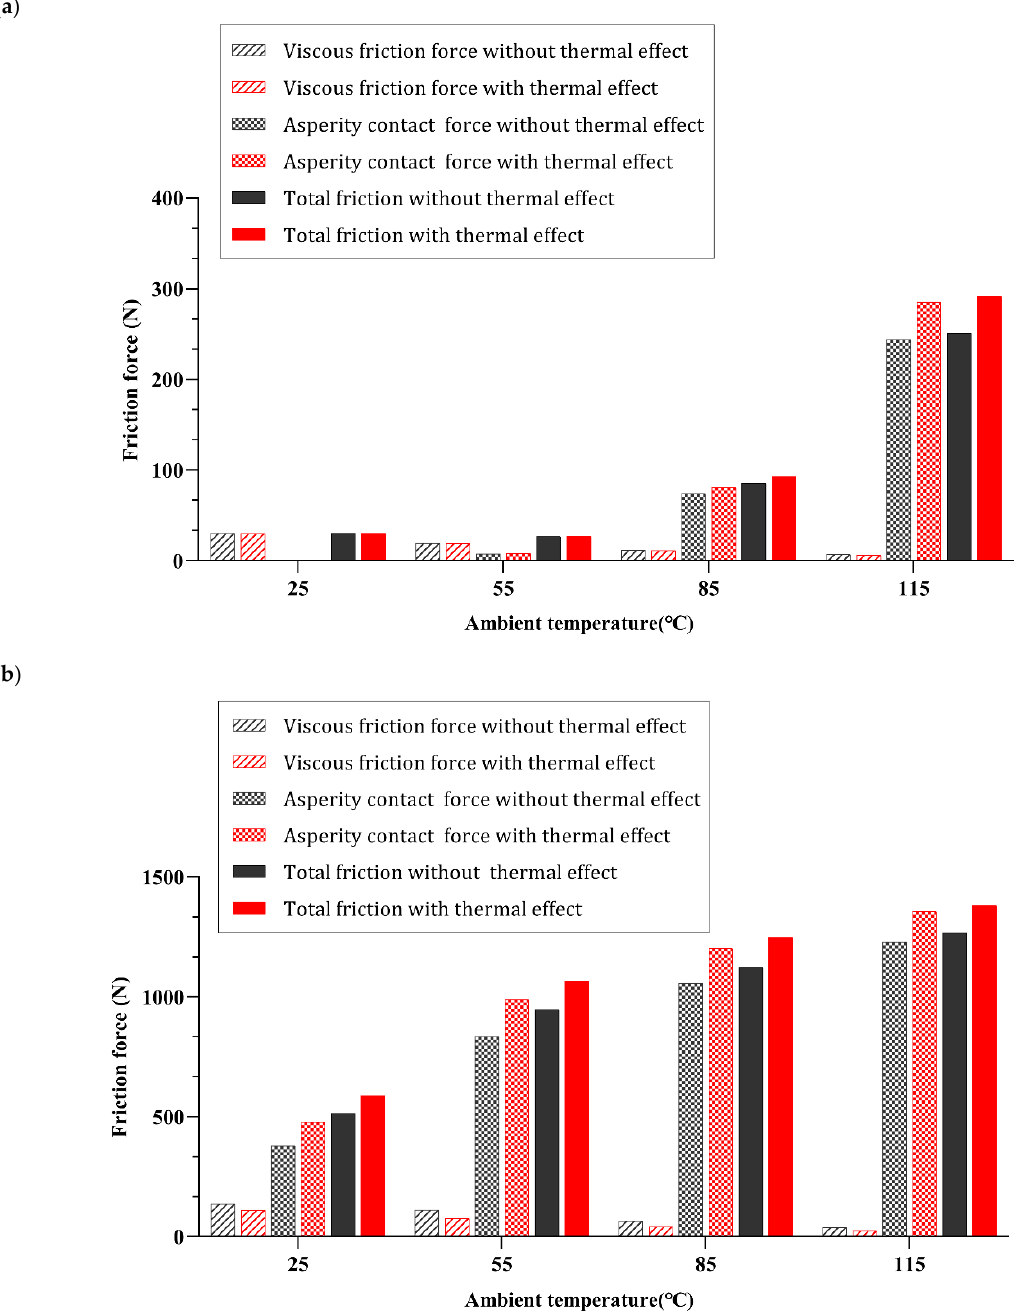
Figure 9. Variation of friction force according to different ambient temperatures and whether thermal effects are considered: ( a ) outstroke and ( b ) instroke .